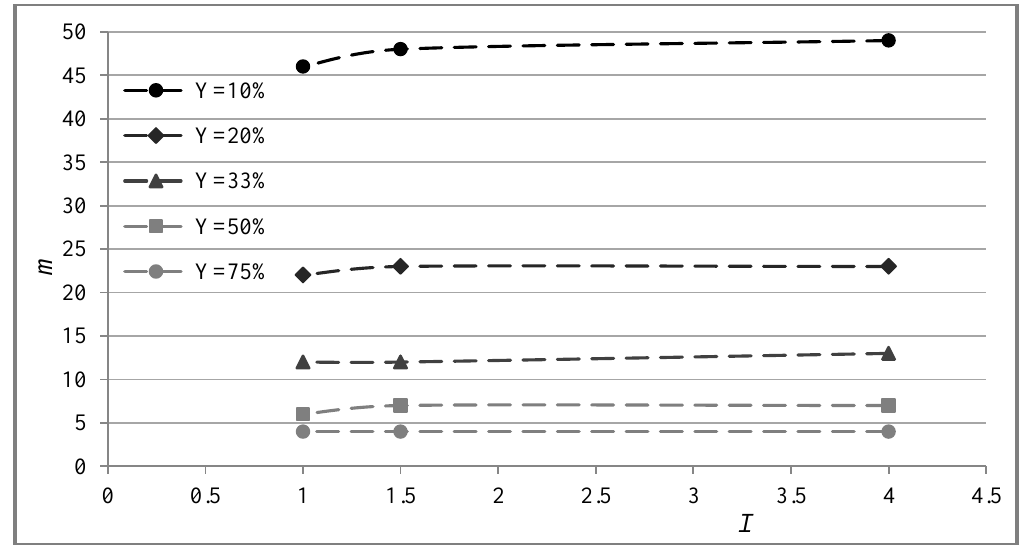
Figure 1. Dependence of the average number of negotiations m on the coalition influence index I at fixed levels of unilateral concessions Y by members of a small